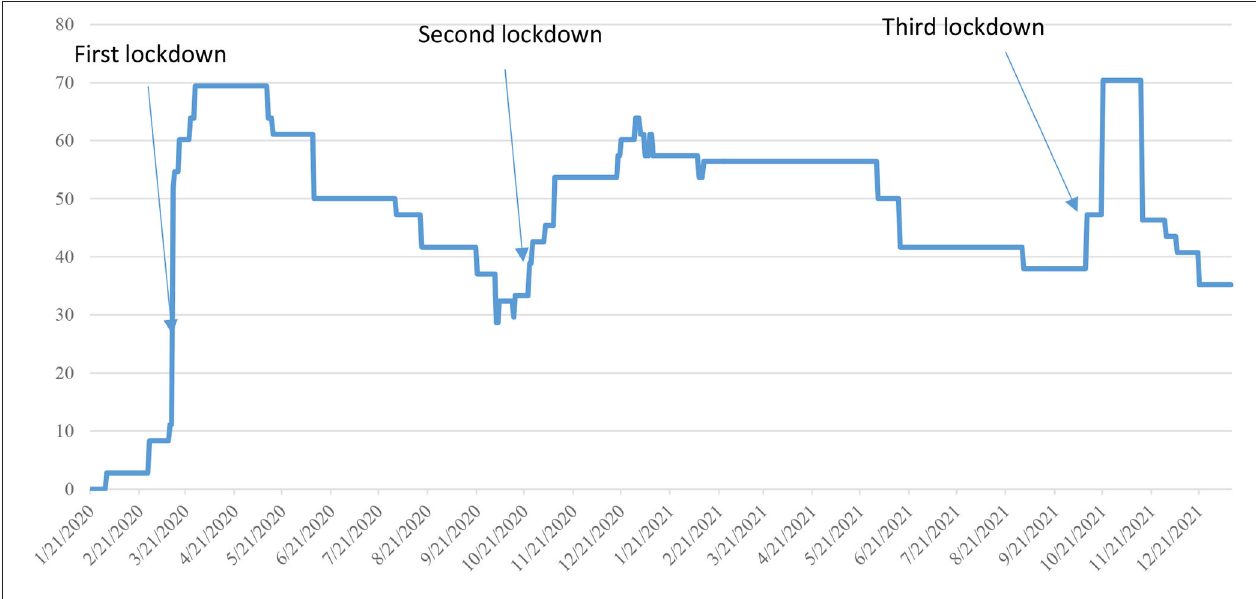
FIGURE 1 | Government stringency index, Latvia, 21/01/2020-21/12/2021 (2).